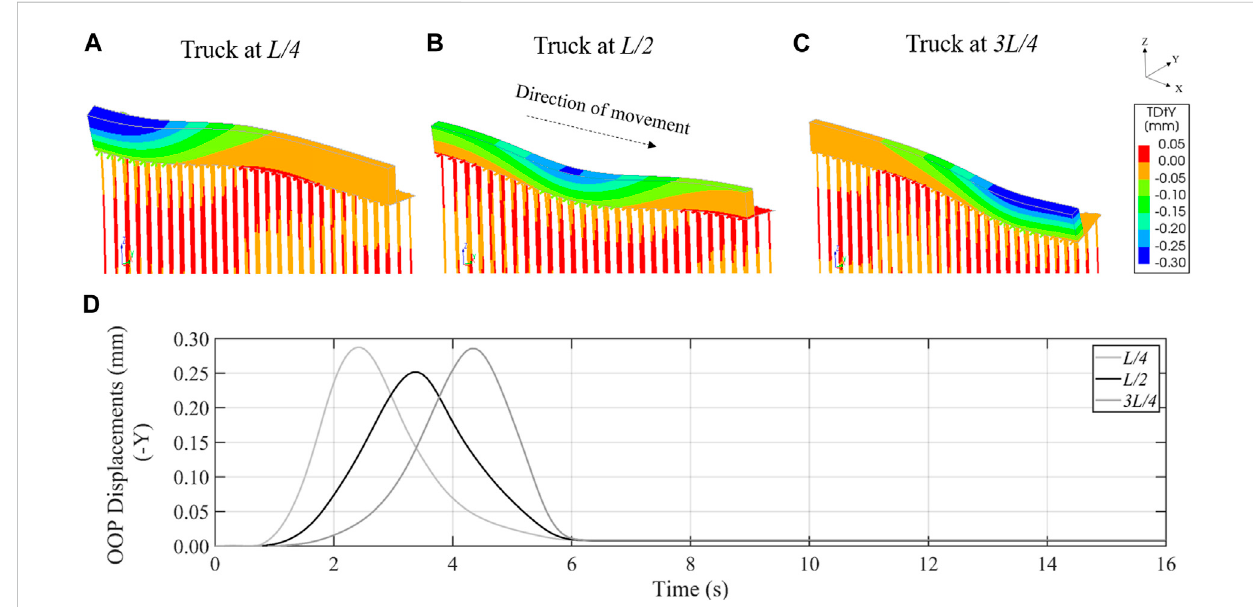
FIGURE 8 Out-of-plane displacements of Model 1 during the passage of the fi re-truck ( LM = 1) at different instants: truck at (A) L/4 ; (B) L/2 ; (C) 3L/4 (Deformation scale factor = 2000) and (D) displacement time-histories at L/4, L/2 and